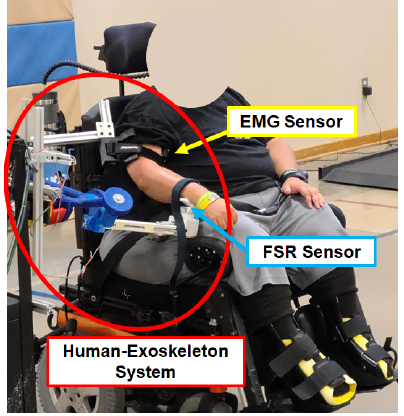
Figure 13. Human-exoskeleton system setup.